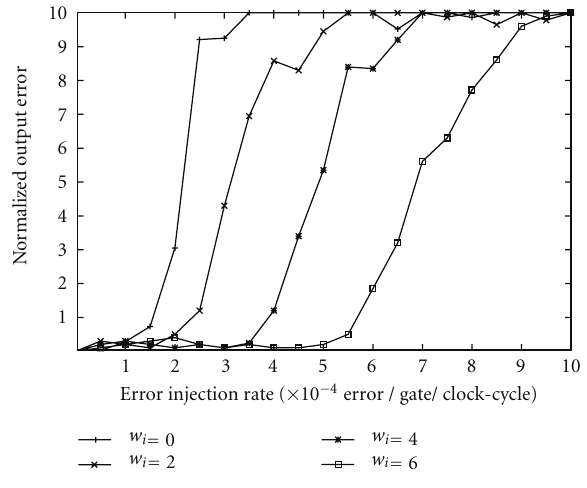
Figure 3: Output error versus error injection rate at di ff erent w i for IME unit.